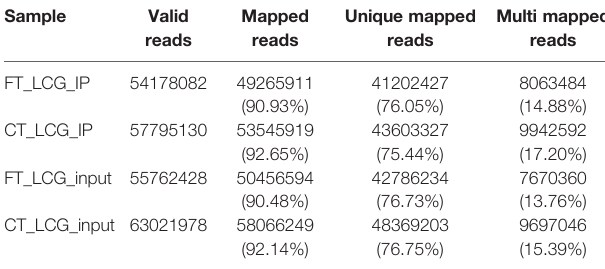
TABLE 2 | Summary of reads mapping to the goat reference